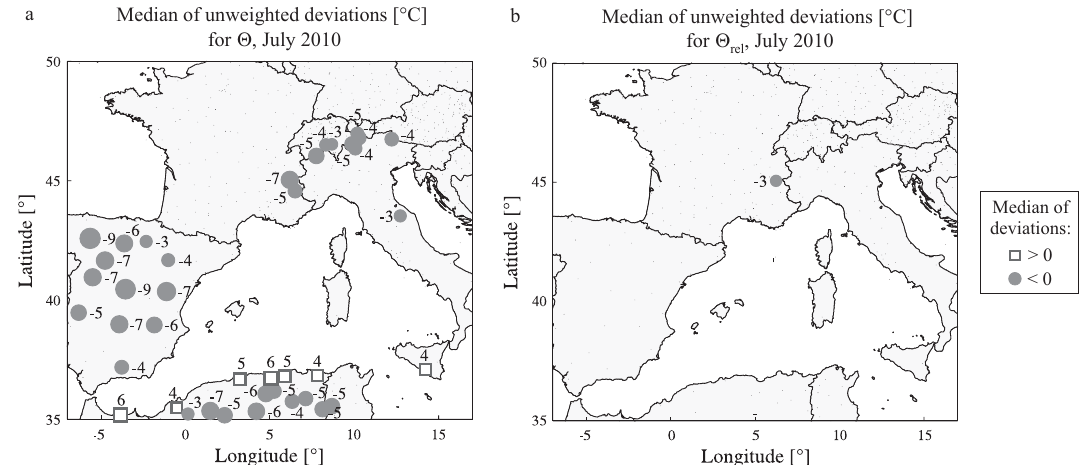
Fig. 5. Comparison of the median of unweighted deviations computed for 2 (a) and for the relative value 2 rel = 2 − 2 ∗ (b) in July 2010 for a domain covering the Southwest Europe. Applying the VERA-QC to the potential temperature 2 (a) , values of elevated stations are reduced systematically (circles), whereas values of neighboring coastal stations are increased (squares). If VERA-QC is applied to the difference between measurements and corresponding values of the standard atmosphere ( 2 rel ), this height depending behavior is reduced significantly (b) . For better visibility, only deviations of | 12 |≥ 3 ◦ C are illustrated.